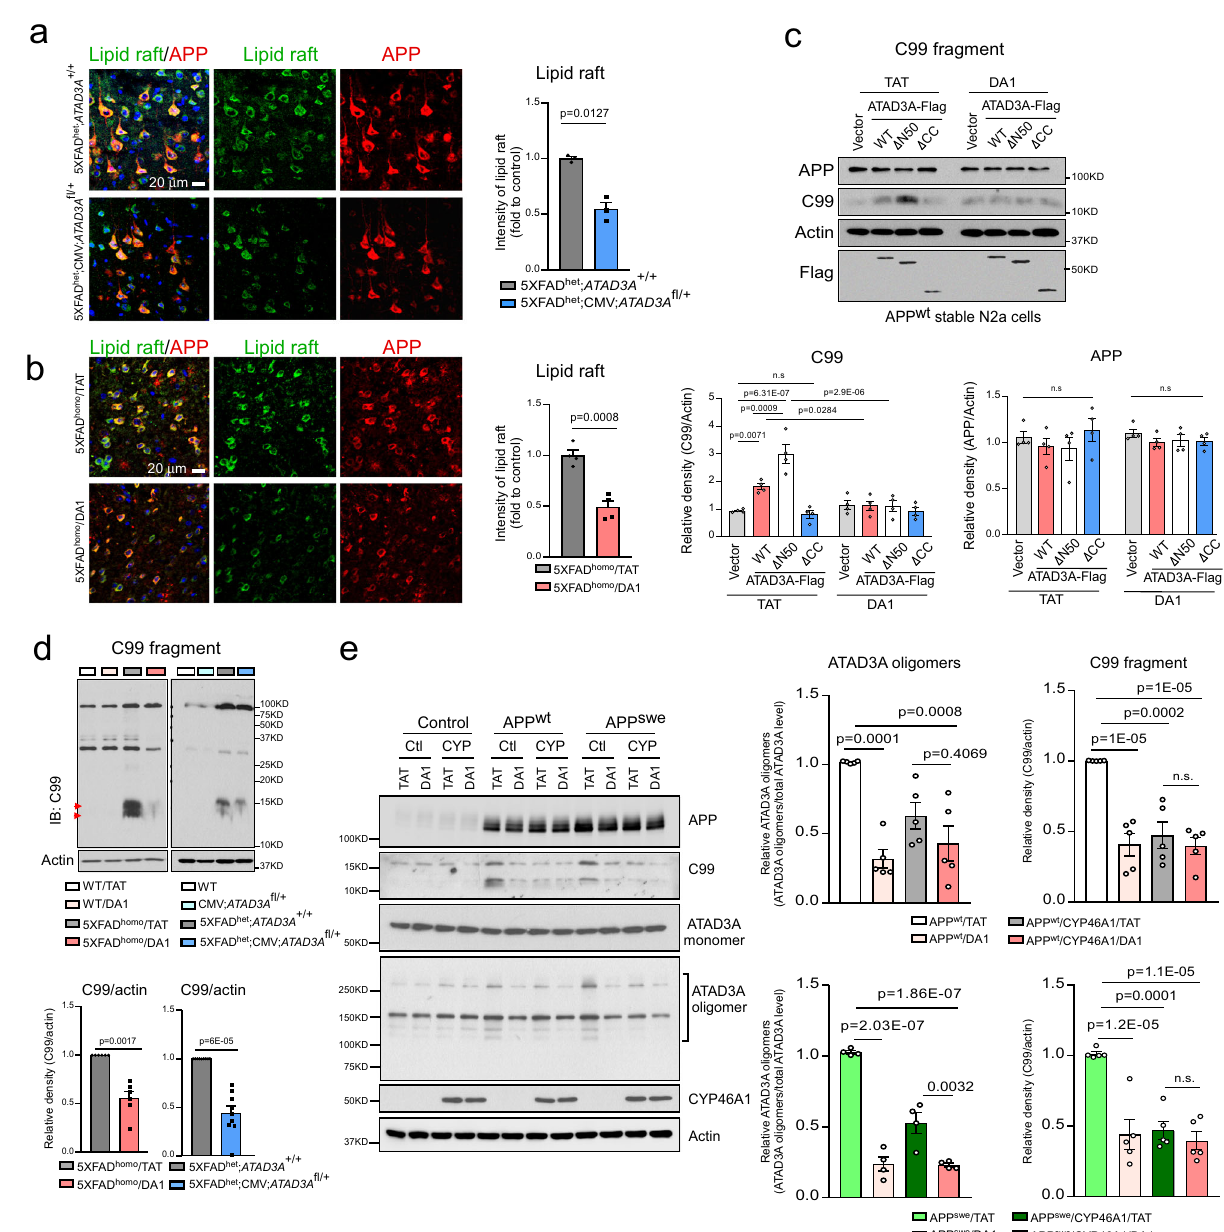
Fig. 6 ATAD3A and CYP46A1 cooperate to promote APP processing. a Brain sections from 3-month-old mice of the indicated genotypes were stained with anti-CTxB (green) and anti-APP (red) antibodies. The intensity of CTxB in the mouse cortex was quanti fi ed from three separate fi elds of each mouse and shown in the histogram ( n = 3 mice/group). b Brain sections from 9-month-old mice of the indicated treatment groups were stained with anti-CTxB (green) and anti-APP (red) antibodies. The intensity of CTxB in the mouse cortex was quanti fi ed from three separate fi elds of each mouse and shown in the histogram ( n = 4 mice/group). c Stable APP wt -expressing Neuro2a (N2a) cells were transfected with ATAD3A-WT-Flag, ATAD3A- Δ N50-Flag, ATAD3A- Δ CC-Flag, or control vector for 24 h, followed by treatment with DA1 or control peptide TAT for 48 h (1 µ M, each). WB was performed. Histogram: the densities of C99 and APP relative to actin ( n = 4 independent experiments). d Total brain lysates were harvested from the cortex of 8- month-old 5XFAD het ;CMV; ATAD3A fl / + group or 9-month-old mice treated with DA1. The APP proteolytic product C99 was assessed by WB (Indicated by red arrow). Histogram: the density of C99 relative to actin ( n = 6 mice for DA1 treated groups, n = 9 mice for 5XFAD het ;CMV; ATAD3A fl / + groups). e CYP46A1 was overexpressed in stable APP wt - and APP swe -expressing Neuro2a cells, which were then treated with DA1 or control peptide TAT (1 µ M for 3 days). WB was performed. Ctl and CYP on the images indicate Control Vector and CYP46A1, respectively. The relative densities of the ATAD3A oligomers and C99 were quanti fi ed ( n = 5). Representative images and blots from at least three independent experiments are shown. All data are presented as the mean ± SEM. The data in a and b were compared by the unpaired Student ’ s t test (two-tailed), and the data in c – e were compared by one- way ANOVA with Tukey ’ s multiple comparisons